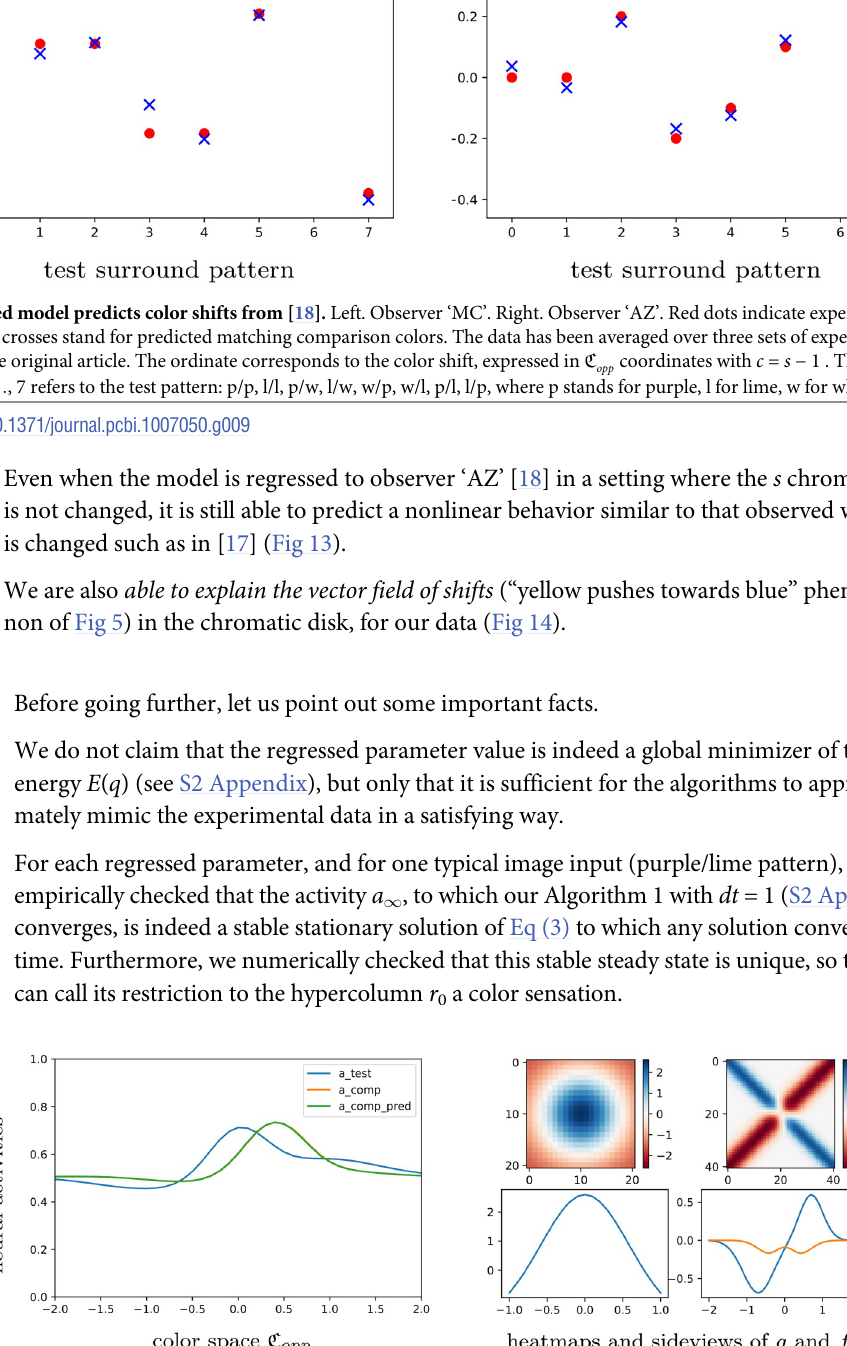
, a comp ½ c match � q q